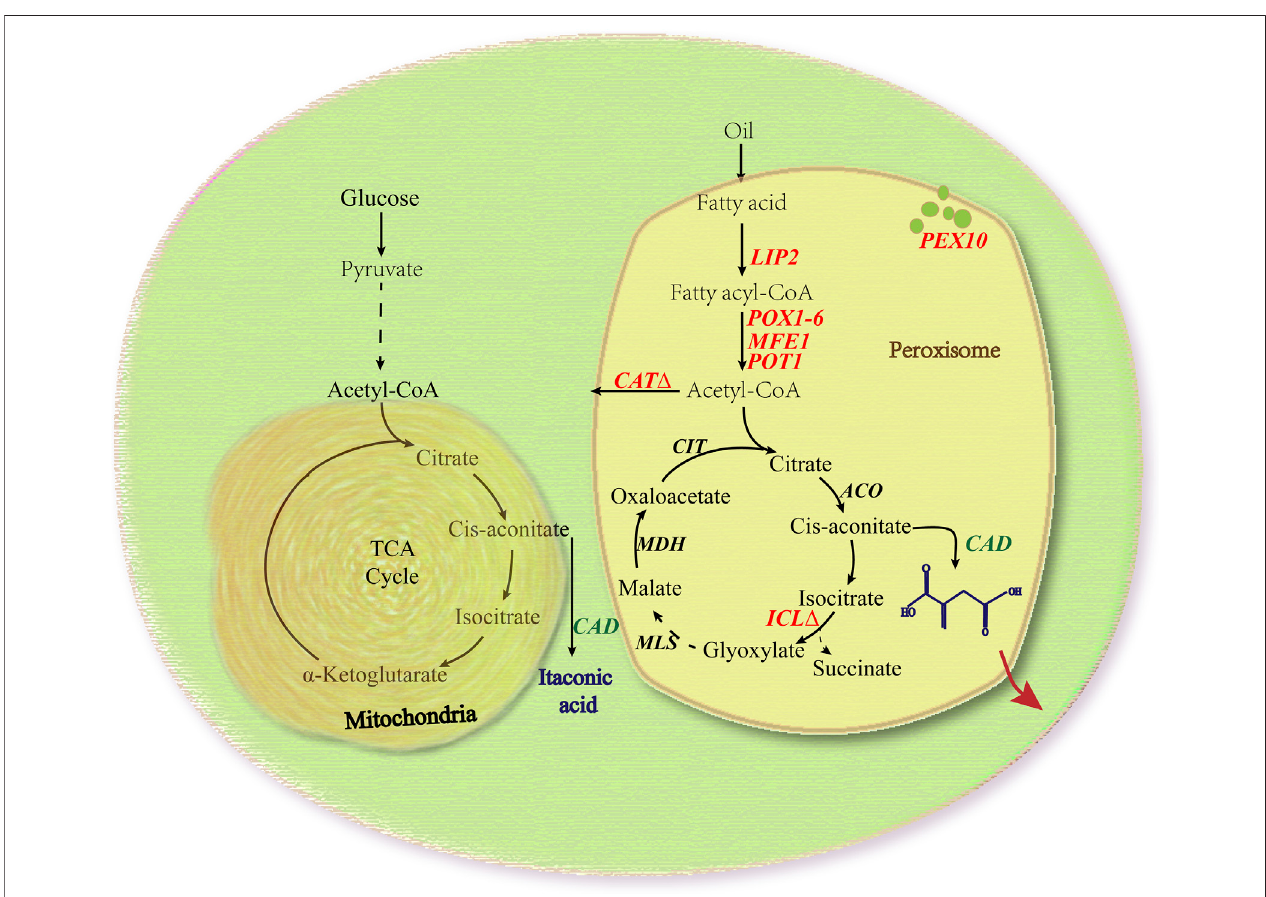
FIGURE 1 | Simpli fi ed schematic of IA biosynthetic pathway in Y. lipolytica . Engineered Y. lipolytica uptakes and converts extracellular carbon sources such as glucose and waste cooking oil into IA products. Genes and metabolites of the native TCA and glyoxylate cycle pathway are identi fi ed in black, while heterologously introduced genes are shown in green and the endogenous genes used in this paper are shown in red. LIP2, lipases; POX1-6, six difffferent acyl-CoA oxidases; MFE1, multifunctional enzyme; POT1, peroxisomal thiolase; PEX10, a proteins required for peroxisome assembly; CAT, carnitine acetyltransferases; ICL, isocitrate lyase; CAD, iso-aconitic acid decarboxylase; ACO, aconitase; MLS, malate synthase; MDH, malate dehydrogenase; CIT, citrate